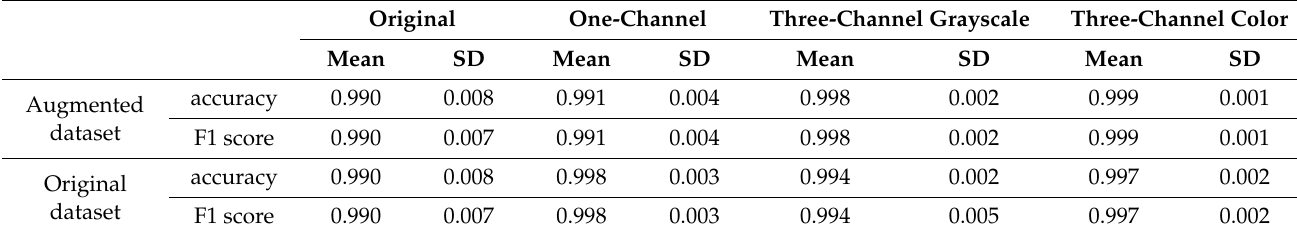
Table 8. Average and standard deviation of MobileNetV2 validation